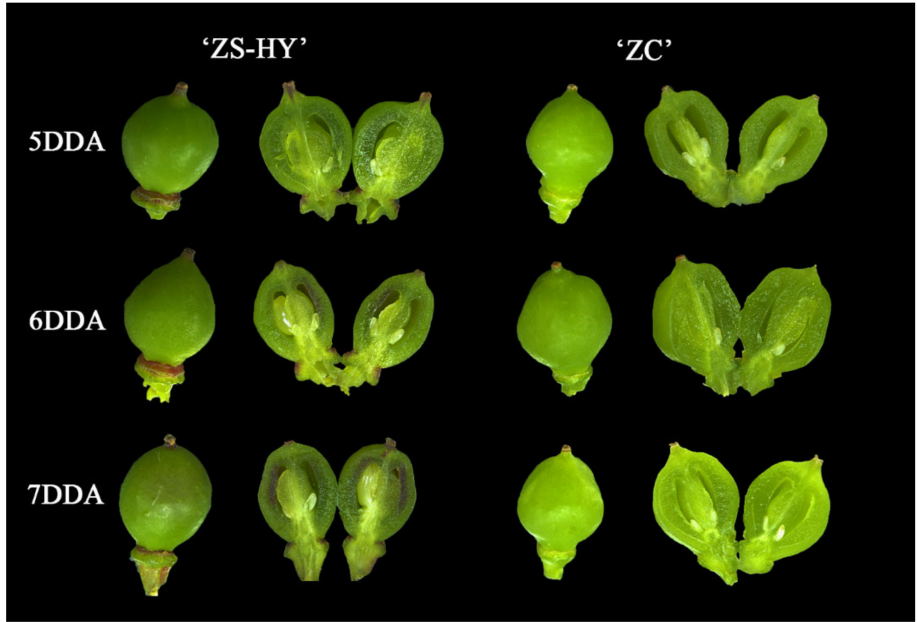
Figure 7. Change in appearance of the flesh color in grapes for 3 consecutive